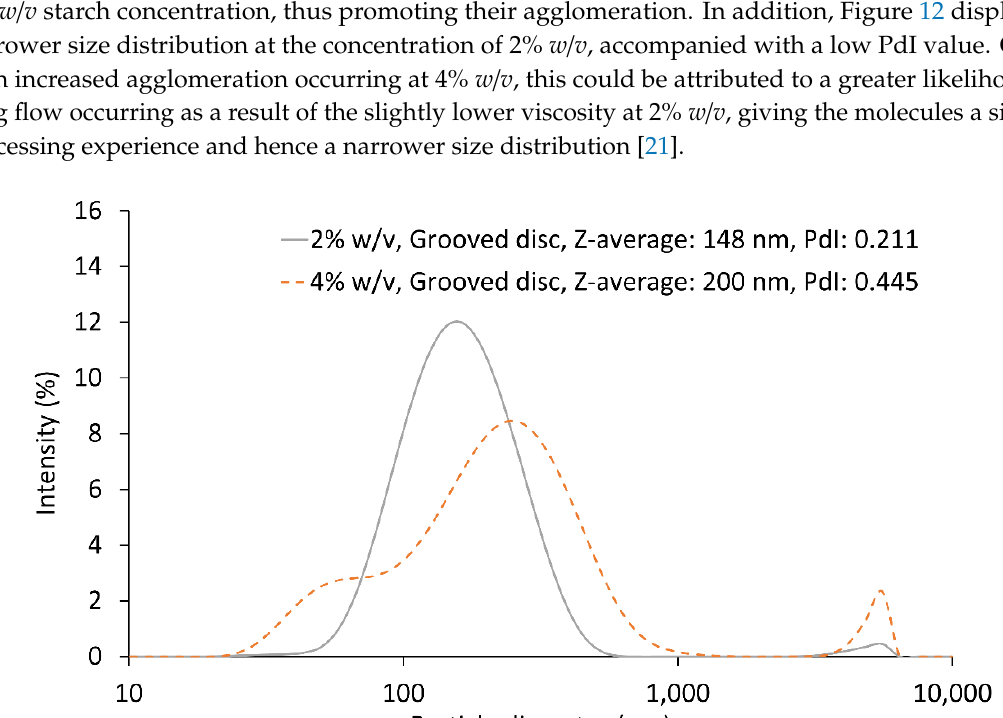
Figure 13. Z-average sizes for 2% w / v and 4% w / v starch highlighting the effect of ( A ) flow rate at 9:1 ratio and 1200 rpm, ( B ) disc speed at 9:1 ratio and 18 mL/s, and ( C ) antisolvent to solvent ratio at 18 mL/s and 1200 rpm. It is to be noted that shear rate was larger at concentrations of 2% w / v than at 4% w / v , with the difference increasing with flow rate and disc speed (Figure 8). A greater shear rate is responsible for the formation of waves and ripples on the surface of the liquid film and for generating instabilities within the film. The greater the instabilities, the more intense the micromixing between the two liquids and the faster the generation of particles [23,30,54]. This would suggest that at 2% w / v nucleation is faster as a result of the high shear causing molecular collisions to a larger extent, without taking into consideration the impact of initial supersaturation on nucleation. However, it is unclear which of the two, shear rate or supersaturation, is more significant in the process of nucleation, and very little has been published on this matter, particularly on a molecular level. To further demonstrate shear rate as a measure of mixing capability in the SDR, micromixing time was calculated through Equation (6), where (cid:2021) , the kinematic viscosity, is a function of the shear